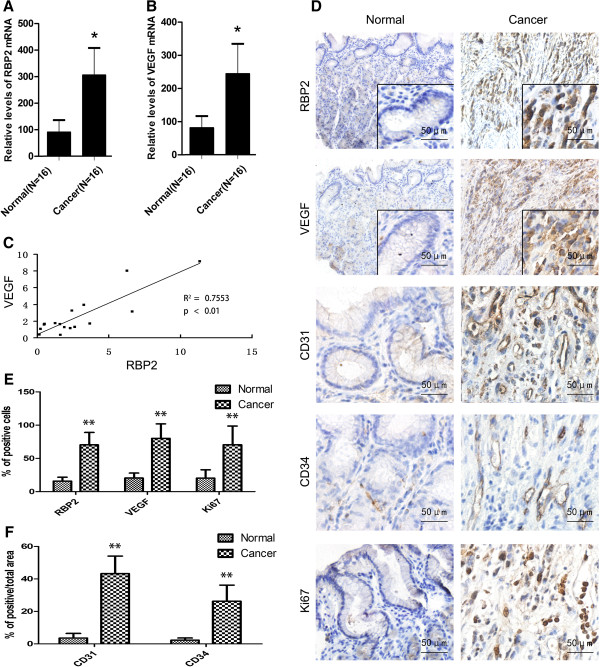
Association of RBP2 overexpression and increased VEGF expression in human gastric cancer. QRT-PCR analyses of (A) RBP2 mRNA and (B) VEGF mRNA in normal and cancerous human gastric tissues. *P < 0.05. (C) Correlation of RBP2 and VEGF levels in human gastric cancer tissues after standardization with matched normal tissues. **P < 0.01. (D) Immunohistochemical staining of expression of RBP2, VEGF, CD31, CD34 and Ki67 in human normal (left panel) and cancerous (right panel) gastric tissues. Representative images are shown. (E) Percentage positive cells by immunohistochemistry for RBP2, VEGF and Ki67 in human normal and cancerous gastric tissues. **P < 0.01. (F) Percentage positive area by immunohistochemistry for CD31 and CD34 in human normal and cancerous gastric tissues. **P < 0.01. Data are mean ± SEM of 3 independent experiments.